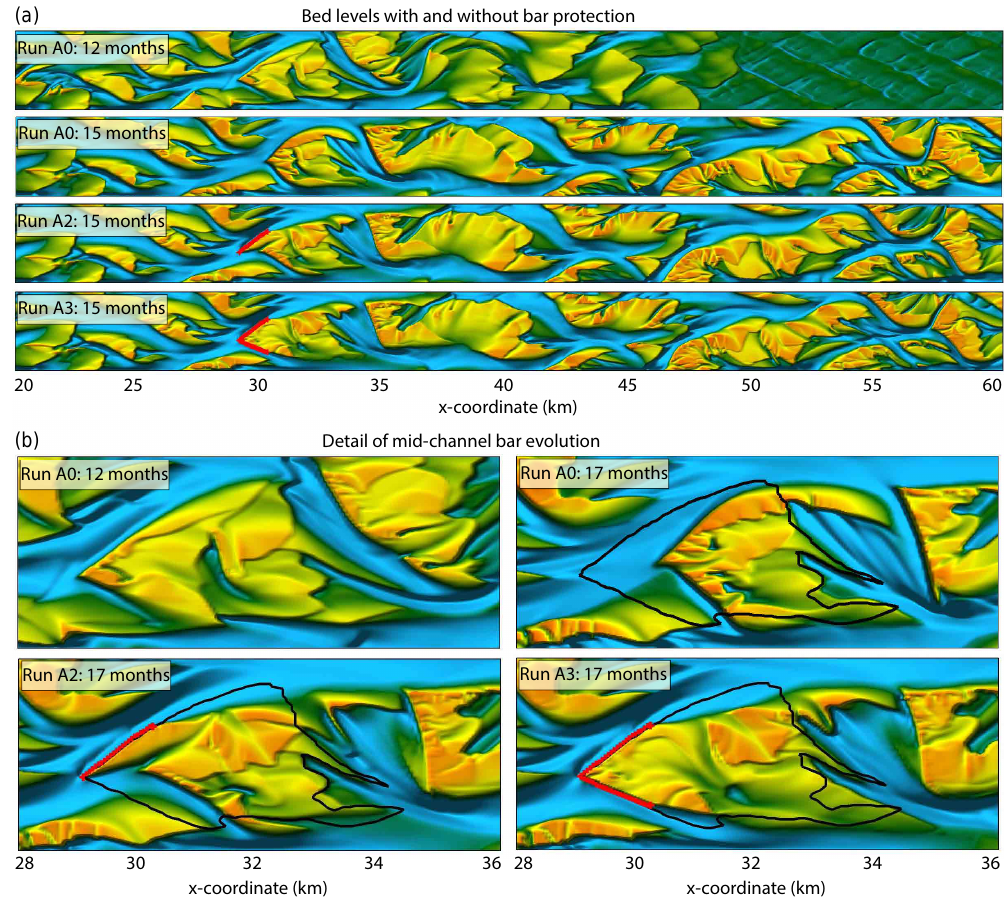
Figure 11. Evolution of the braided channel network and bar patter in Run A2 and Run A3 with bar protections: (a) reach-scale development and (b) detail of the development of the protected bar with the bar protection (red line) and initial bar perimeter (black line).